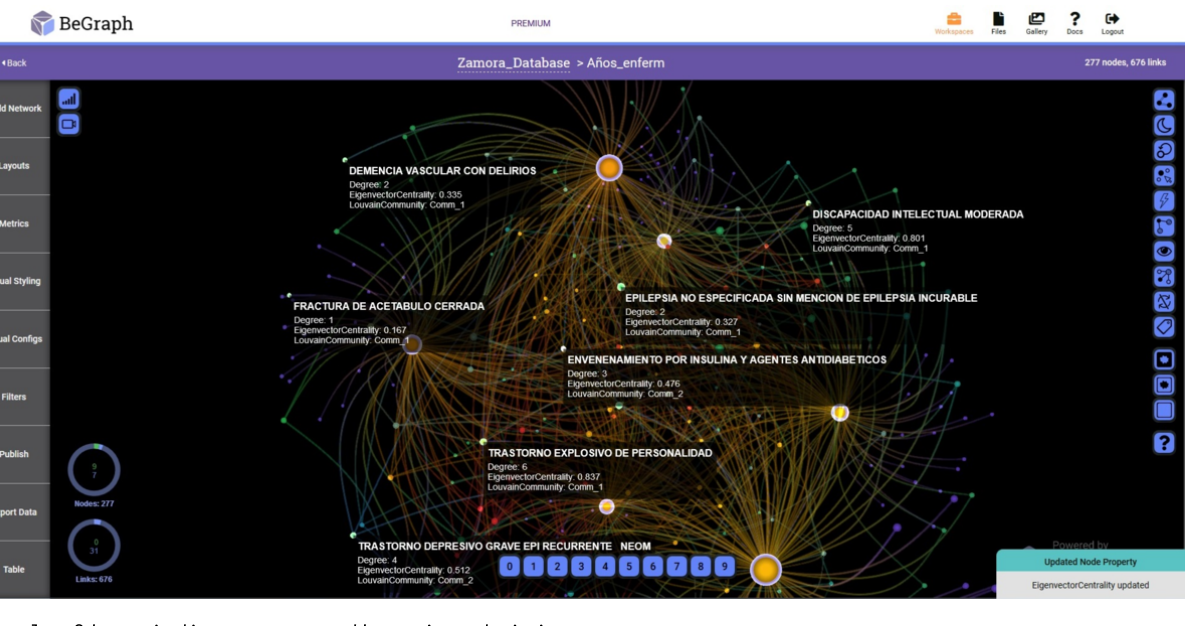
Figure 3. Network with prevalent diseases-years in the Rio Hortega Hospital of Valladolid.